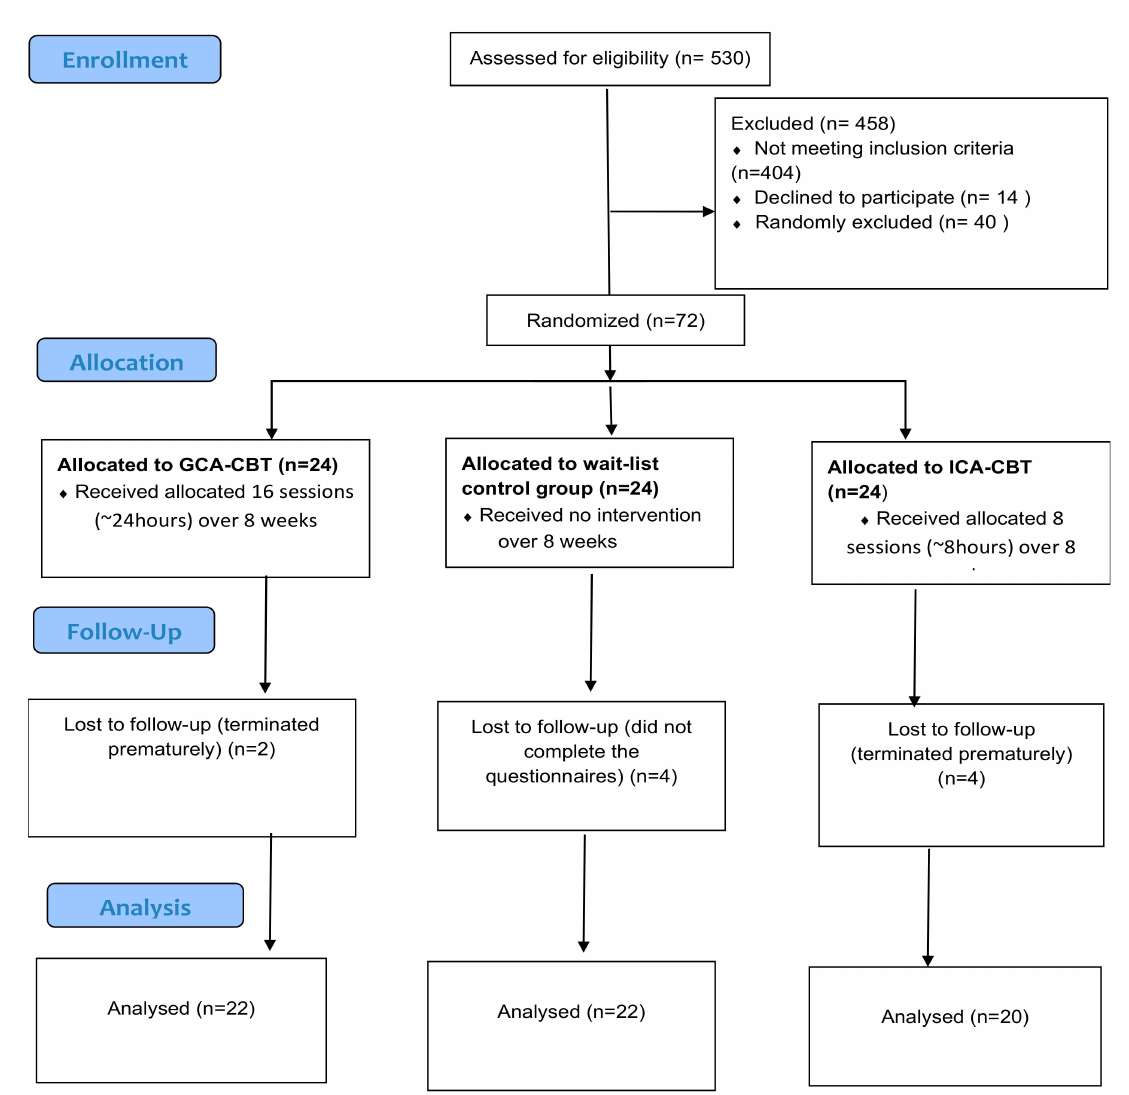
Figure 3. CONSORT Flow Chart of the randomized controlled trials (RCT) parallel arm for sampling